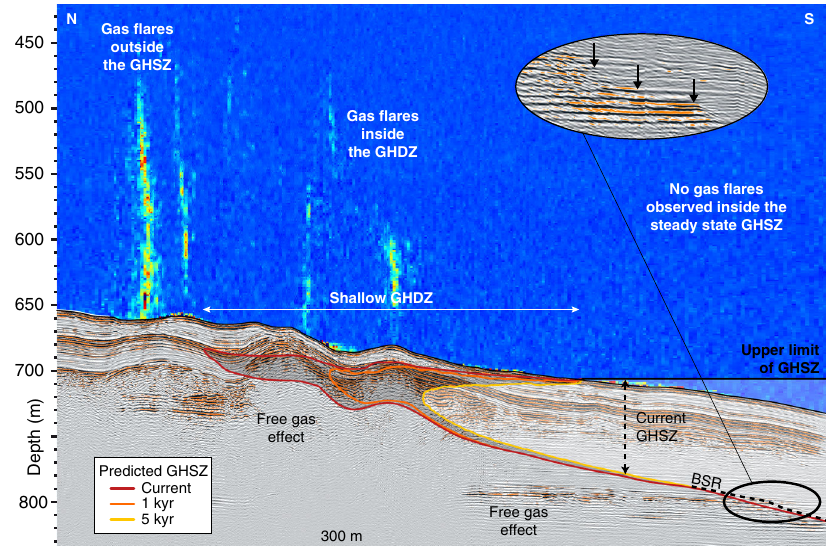
Fig. 4 Methane hydrate dissociation due to salt diffusion responsible for gas fl ares. The interpretation of a pre-stack depth migrated VHR seismic section (acquired with the deep-towed Sysif multi-channel system) shows the free gas trapped under the BSR. It corresponds to an increase in the attenuation and amplitude anomalies (black arrows). Due to salinization of sediment, the dissociation of GH is expected to evolve over the next several thousand years (colored lines simulate the model-predicted evolution of the GHSZ at two different time steps). The processed water column echogram along the Sysif line (close-up view of part of the HR seismic pro fi le presented in Fig. 2) shows the location of the gas fl ares outside the current GHSZ and inside the shallow GHDZ, which matches positively with the free gas location and the predicted GHSZ